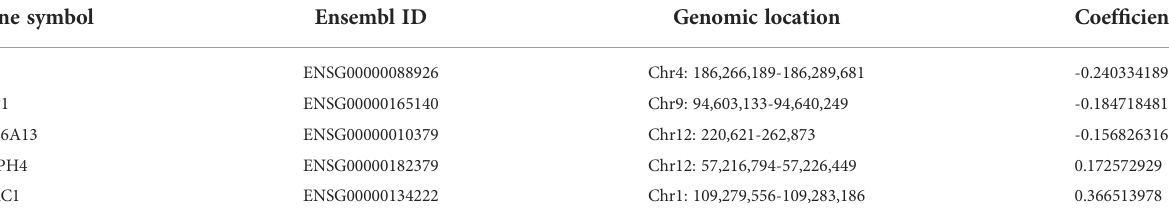
TABLE 1 The coef fi cients of 5 RBP-related mRNAs by the multivariable Cox regression analysis in the training cohort. Gene